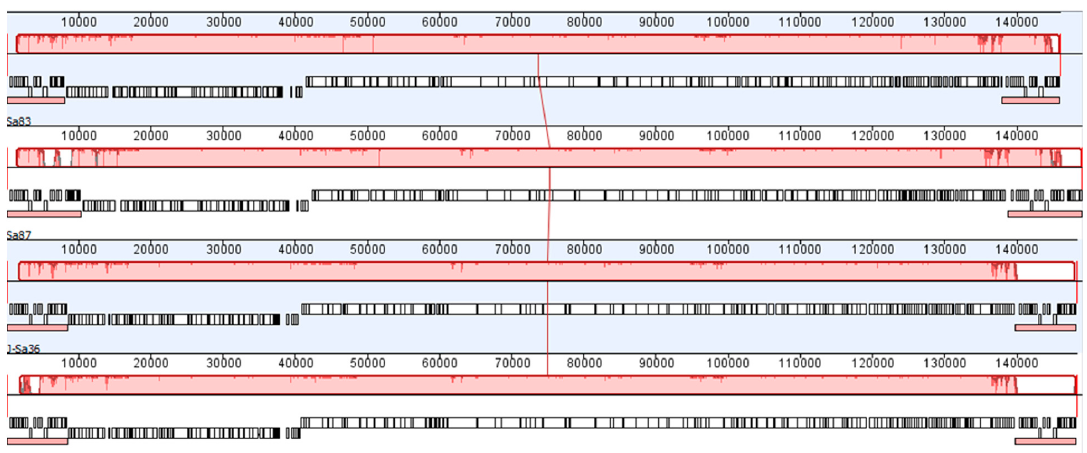
Figure 2. A Progressive Mauve alignment of (top to bottom) Sa83, Sa87, J-Sa36, and phage K (GenBank K766114), each showing annotated genes (white boxes) and long terminal repeats (small red boxes immediately below white gene blocks). The large red blocks above each annotated genome (connected by the red vertical line at approximately 75 kb) represent local collinear blocks of genomes identity; interruptions in these red blocks indicate differences among the four aligned nucleotide sequences. Table 1. In vitro antibacterial activity of AB-SA01 and its component phages on Staphylococcus aureus . Panel